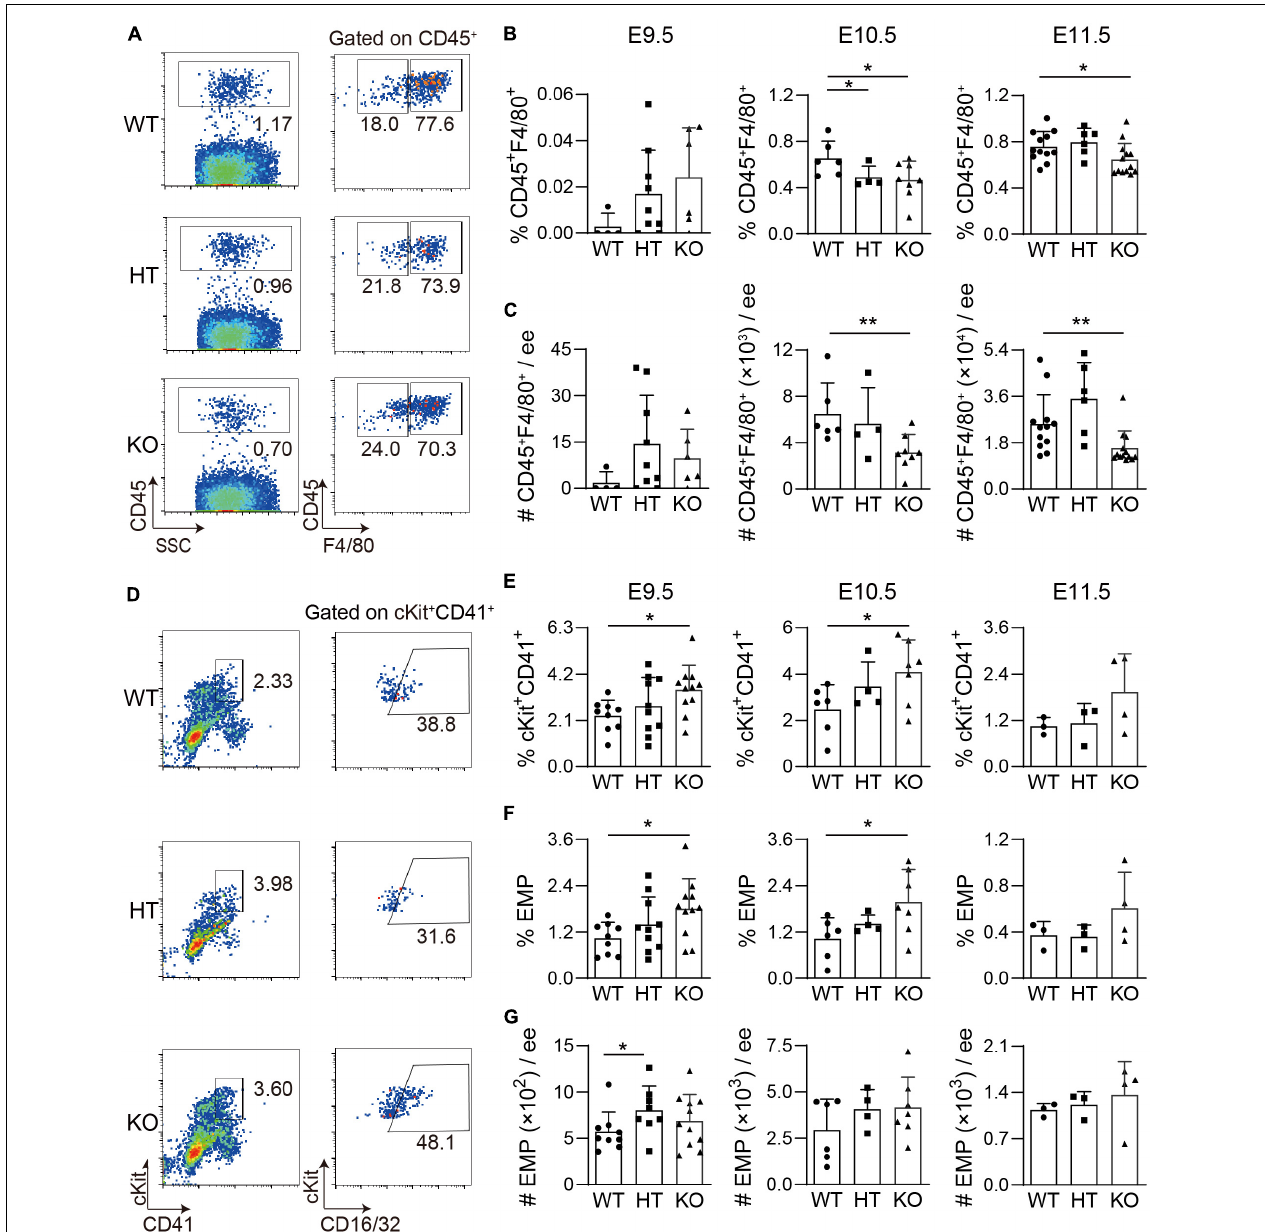
FIGURE 3 | The development of microglia and related cell population in the Wip1 ablation embryonic head/yolk sac. (A) Representative flow cytometry analysis of CD45 + cells and F4/80 + microglia of the E11.5 embryonic head. (B) The percentages of CD45 + F4/80 + E9.5–E11.5 embryonic head. * p < 0.05. (C) The absolute numbers of F480 + CD45 + cells in E9.5–E11.5 embryonic head. E9.5, n = 4; E10.5, n = 3; E11.5, n = 6; ** p < 0.01. (D) Representative flow cytometry analysis of ckit + CD41 + cells and erythro-myeloid progenitors (EMPs) in the E9.5 yolk sac. (E) The percentages of ckit + CD41 + cells in the E9.5-E11.5 yolk sac. E9.5, n = 5; E10.5, n = 3; E11.5, n = 3; * p < 0.05. (F,G) The percentages and absolute numbers of EMPs (ckit + CD41 + CD16/32 + ) in the E9.5–E11.5 yolk sac. E9.5, n = 5; E10.5, n = 3; E11.5, n = 3; * p <